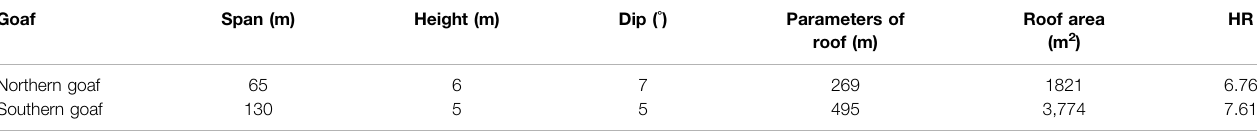
TABLE 2 | Hydraulic radius HR of the north and south goaf.